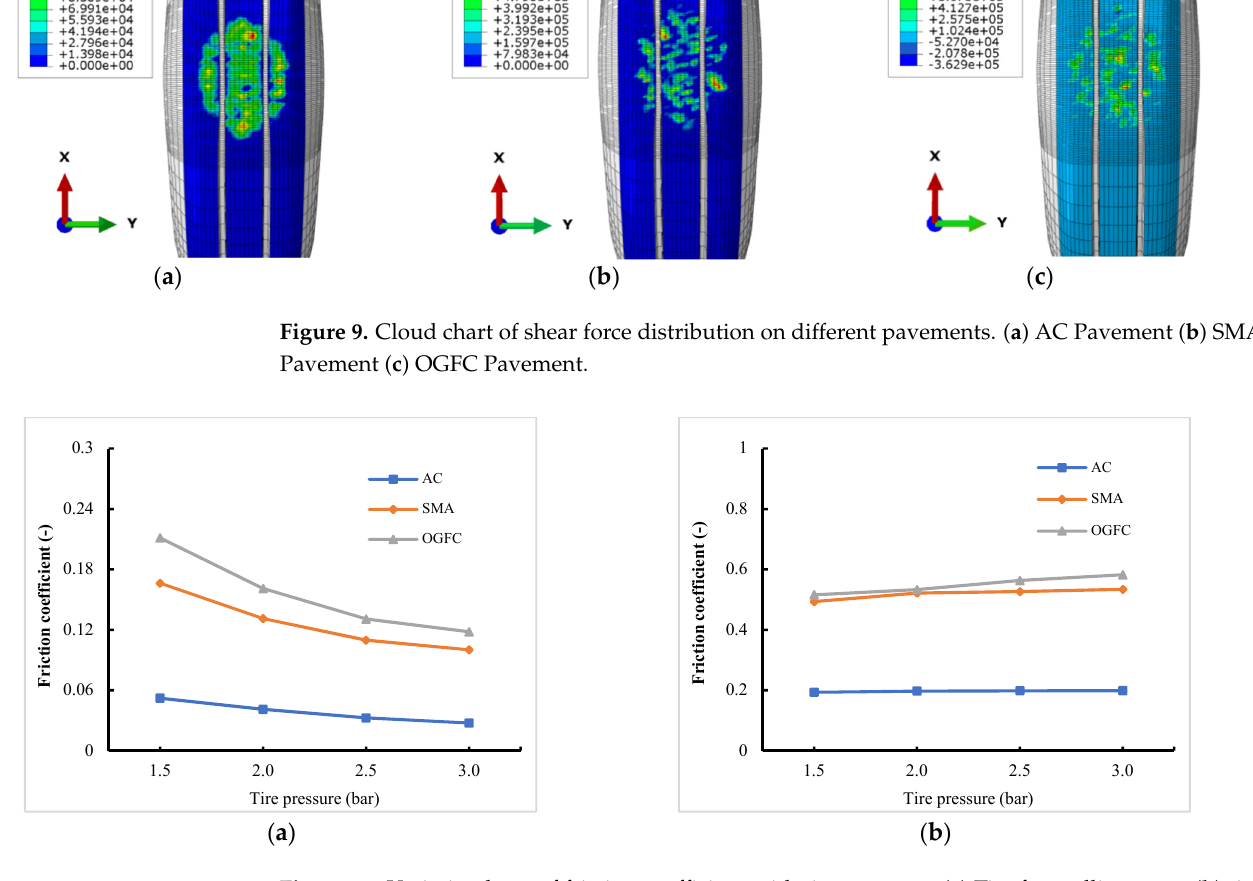
Figure 10. Variation laws of friction coefficient with tire pressure. ( a ) Tire free rolling state; ( b ) tire braking